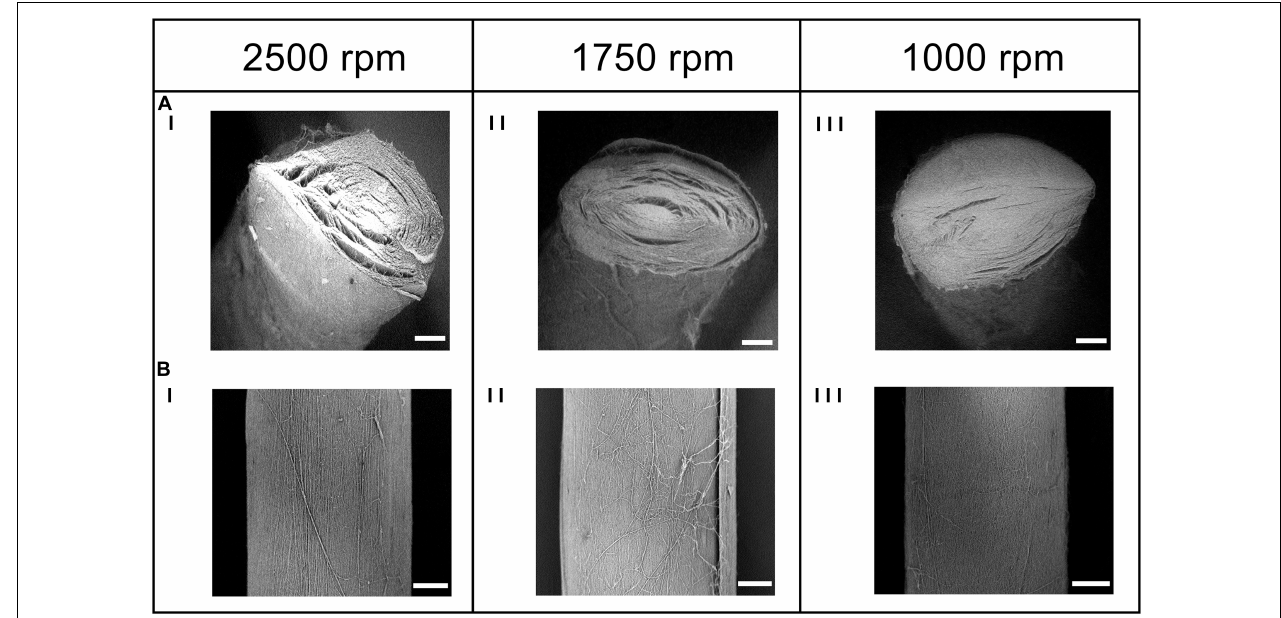
FIGURE 4 | SEM investigation of the (A) cross-section (magnification = 200 × ; scale bar = 100 µ m) and the (B) body (magnification = 260 × ; scale bar = 100 µ m) of the electrospun bundles at: (I) 2,500 rpm, (II) 1,750 rpm and (III) 1,000 rpm.